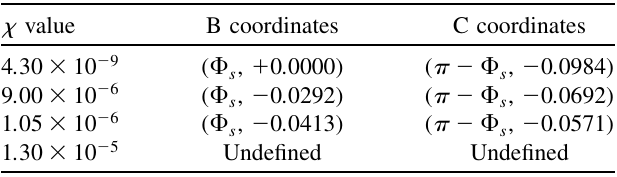
TABLE II. Coordinates of the stable fixed points in function of the (cid:6) value for the first and second bucket series of Fig. 2. (cid:6) value B coordinates C